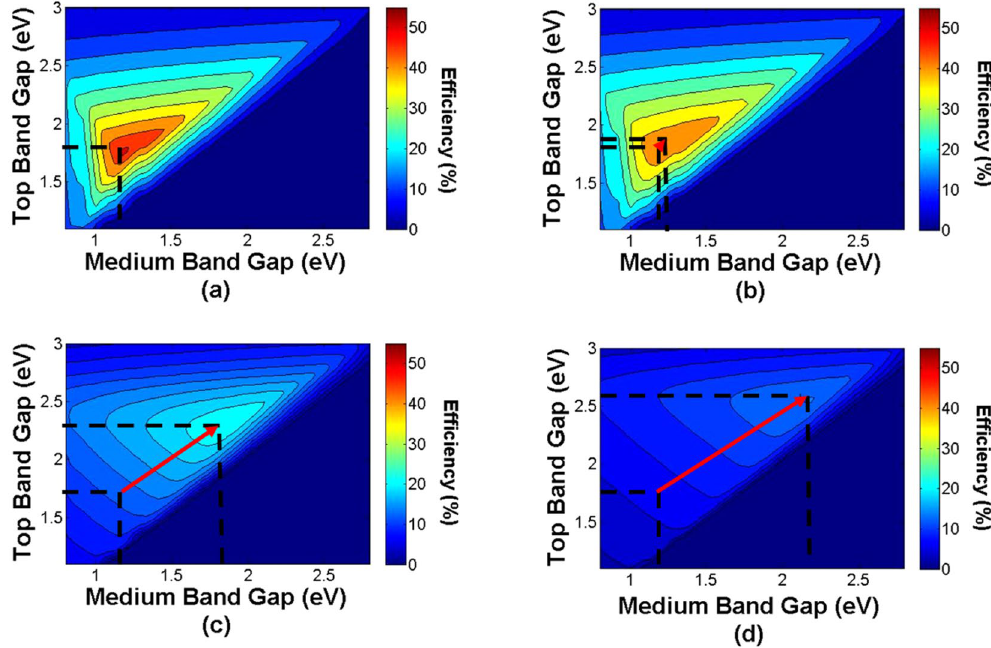
Figure 2. Iso-efficiency curves of 3-J cells with a total series resistance of 0.05 Ω cm 2 and for illumination levels